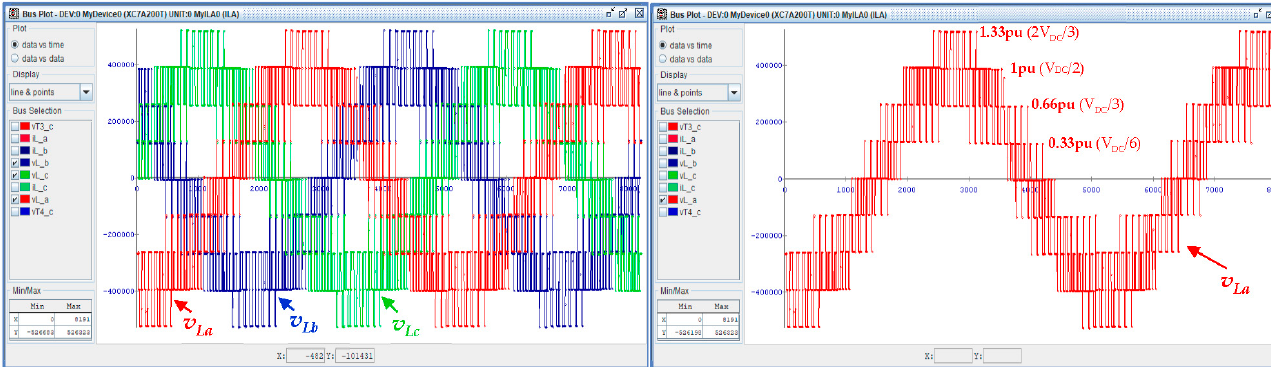
Figure 14. RT results—waveforms of the load voltages and currents obtained with three-phase volt- age references set to 0.9 pu amplitude and 200 Hz frequency.